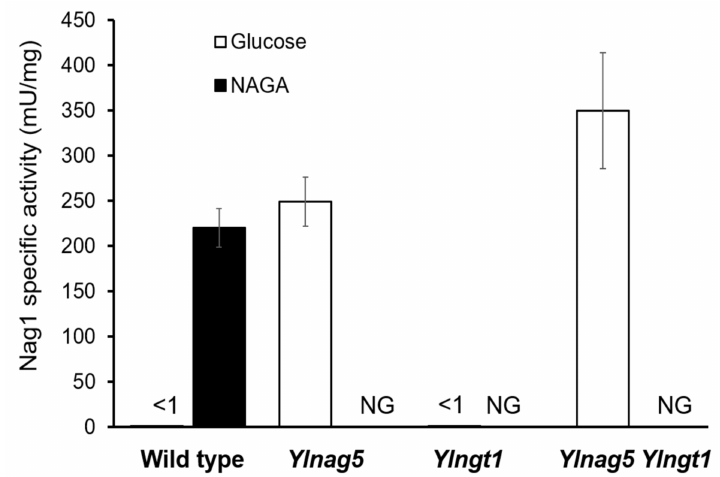
Figure 3. Specific activity of Nag1 in strains carrying disrupted versions of YlNAG5 and YlNGT1 . The indicated strains were grown in glucose or NAGA, and Nag1 activity was assayed as described in Material and Methods. The values are means with standard deviations from three independent cultures. The activity was <1 mU/mg protein in the cases in which no column bar is visible. NG, no